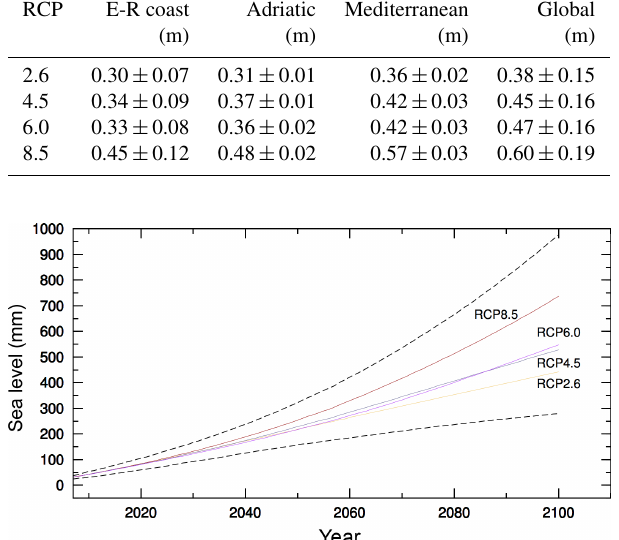
Figure 3. Sea-level pathways according to IPCC AR5. Dashed lines show the lower and the upper limits of the projections, correspond- ing to the upper limit of RCP 8 . 5 and to the lower limit of RCP 2 . 6. Projections are referred to the average sea-level values in the period